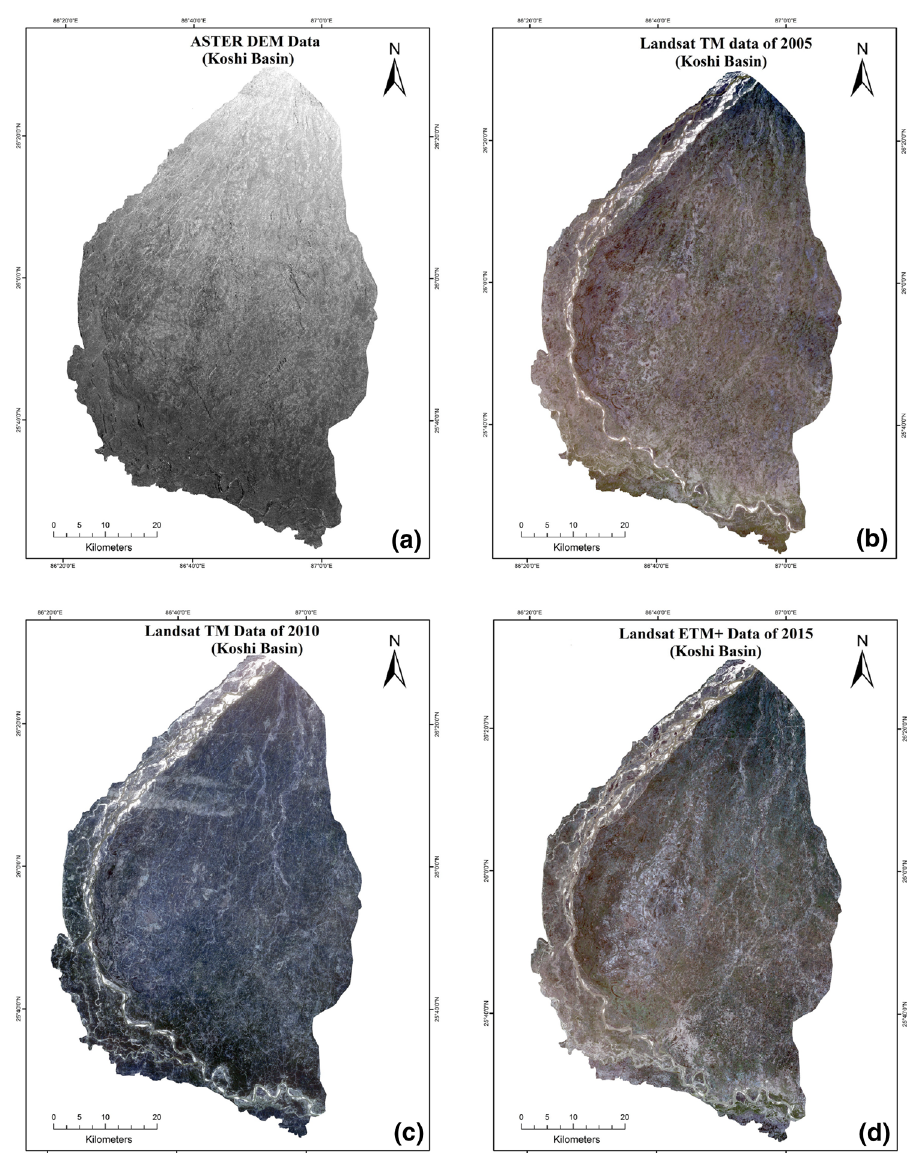
Fig. 2 Remote sensing